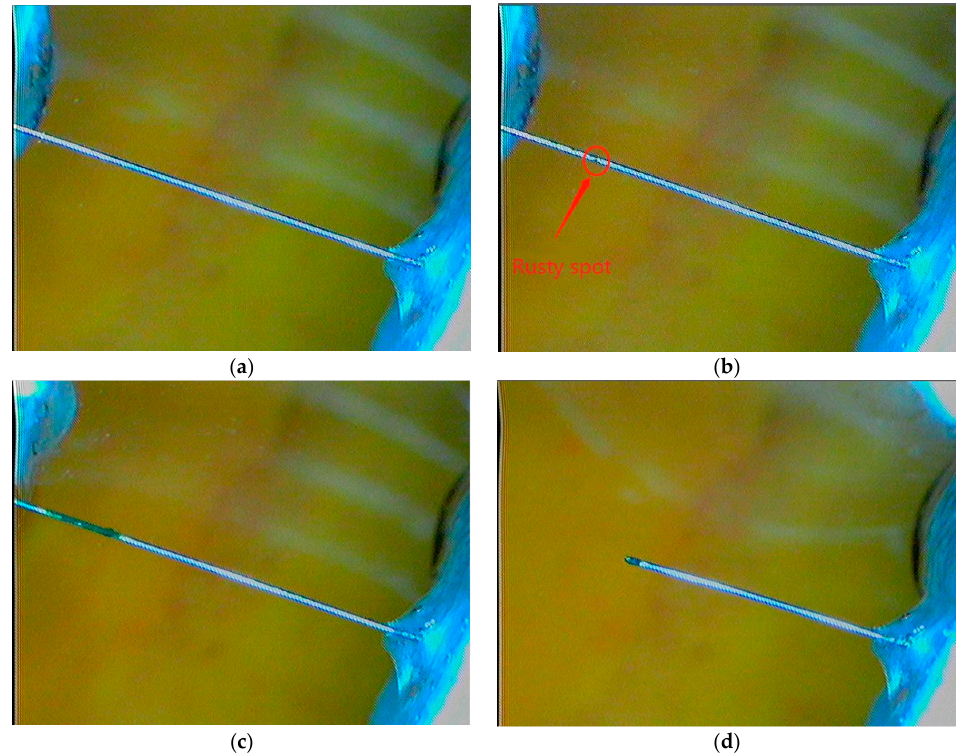
Figure 3. Images of steel wire at different stages. ( a ) Immediately after immersed into solution, ( b ) corrosion just initiated where a rust spot was viewed, ( c ) corrosion in development where corrosion region has been developed, and ( d ) after wire breaks (The details about when and under what experimental conditions these photos were taken are given in Figure 4, respectively).